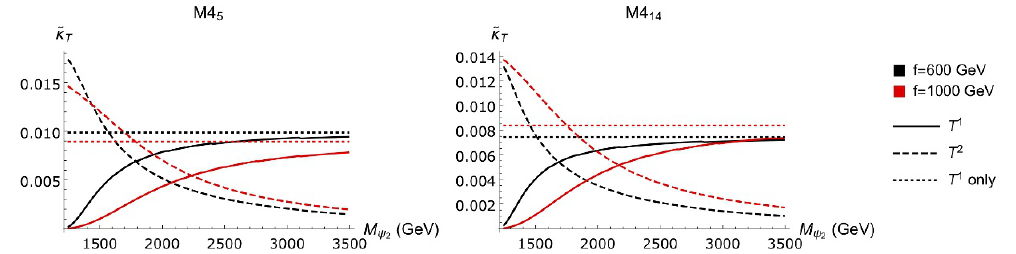
Figure 7 . The CP-odd Yukawa couplings of the two top-partners T 1 and T 2 as functions of the heavier vector-like mass M (cid:9) , for M (cid:9) = 1200 GeV, y = 1, c = 0 : 2 and f = 600 = 1000 2 1